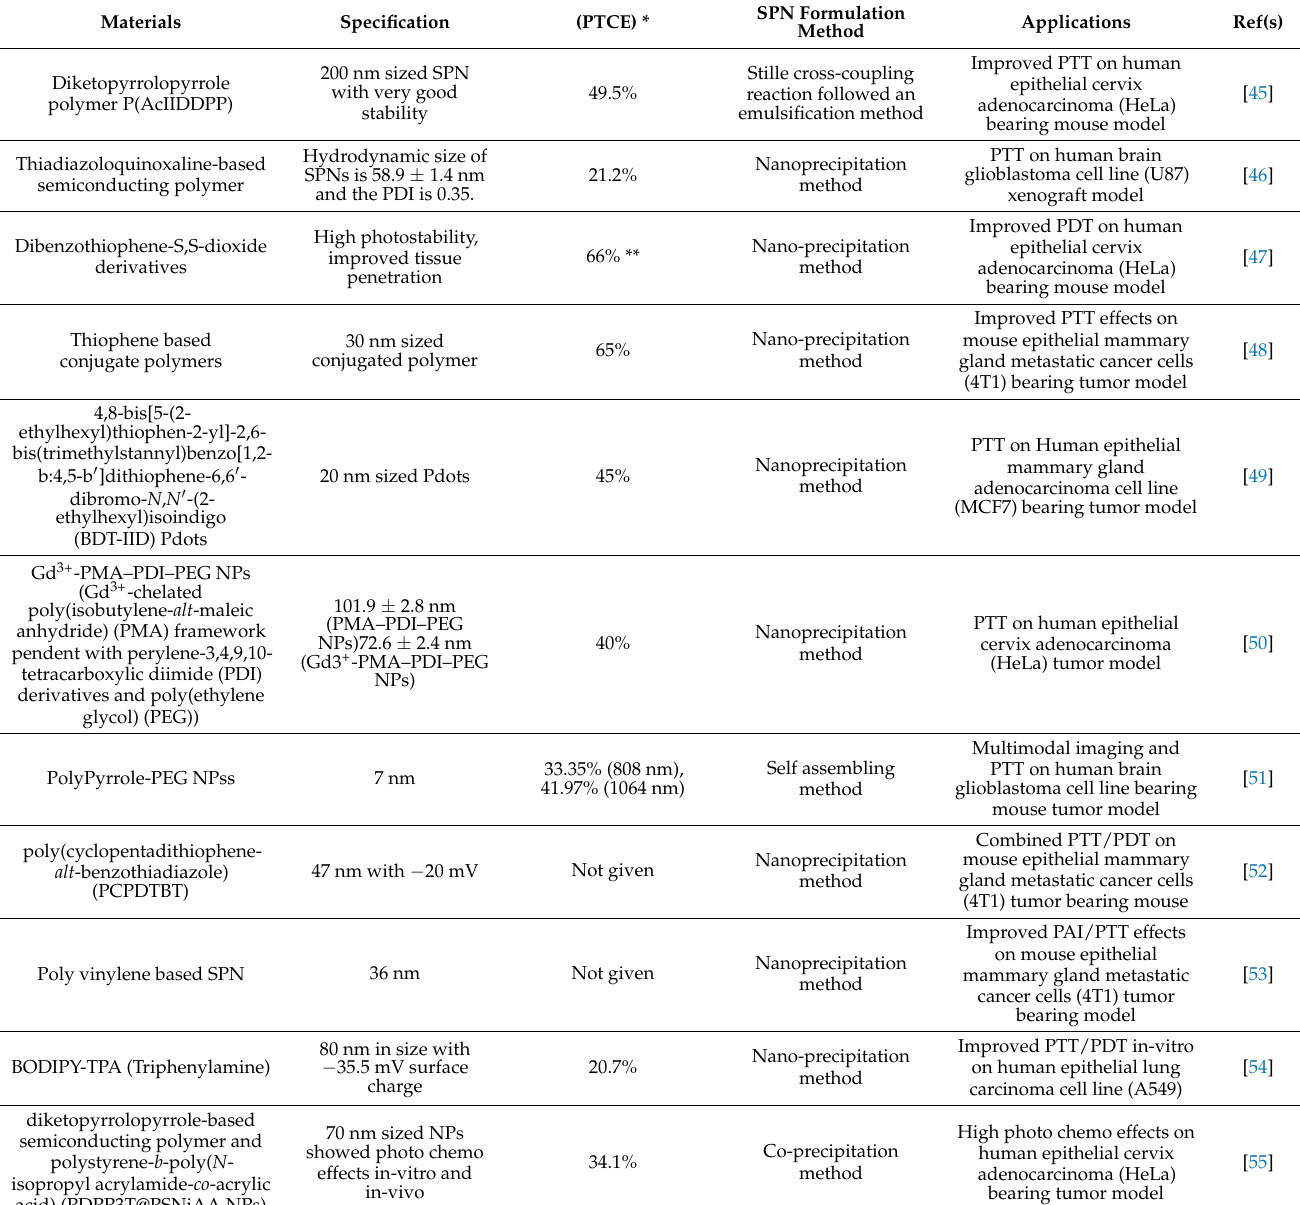
Table 1. Various emerging SPN systems studied during last 5 years